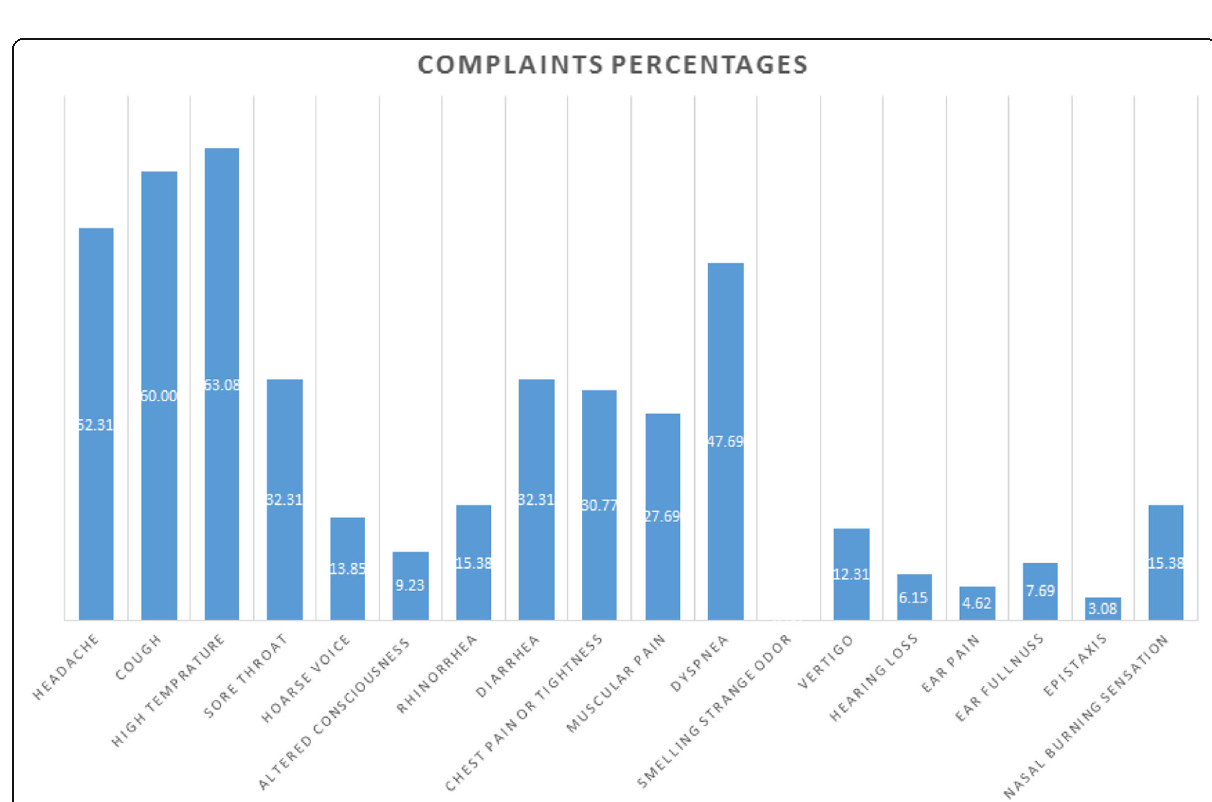
Fig. 6 The percentage of each symptom in COVID-19 patients